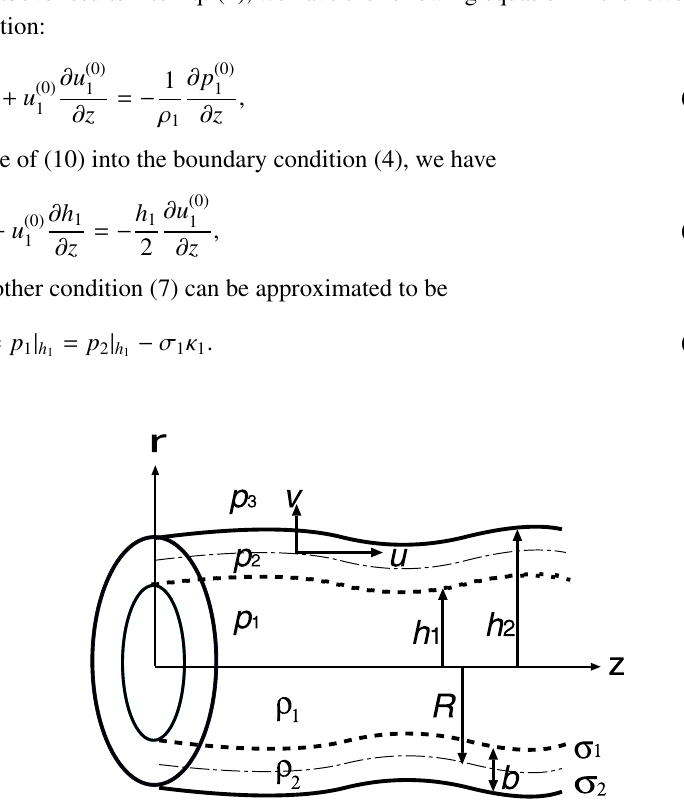
Fig. 1 Schematic of the compound liquid jet.